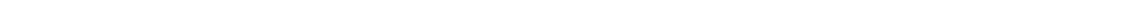
Fig. 1 Short and long-range resection occurs at terminally arrested forks. a Scheme of the RTS1 -RFB (red bar) integrated 5 kb away from a strong replication origin (ori). The RTS1 -RFB has been integrated at the ura4 locus, where most forks travel from the centromere-proximal origin toward the telomere. “ Cen3 ” indicates centromere position. Distances between replication origins and the RTS1 -RFB are indicated. 16 h after thiamine removal, forks traveling from the centromere toward the telomere are blocked in a polar manner. b Diagrams of constructs containing the reporter gene ura4-sd20 , associated or not to the RTS1 -RFB (Supplementary Fig. 1). The ura4-sd20 allele contains a 20 nt duplication fl anked by 5 bp of micro-homology 49 . When the ura4-sd20 allele is replicated by a restarted fork, the non-processive DNA synthesis undergoes replication slippage resulting in the deletion of the duplication and the restoration of a functional ura4 + gene. c Frequency of upstream and downstream RFB-induced Ura + reversion. Each dot represents one sample